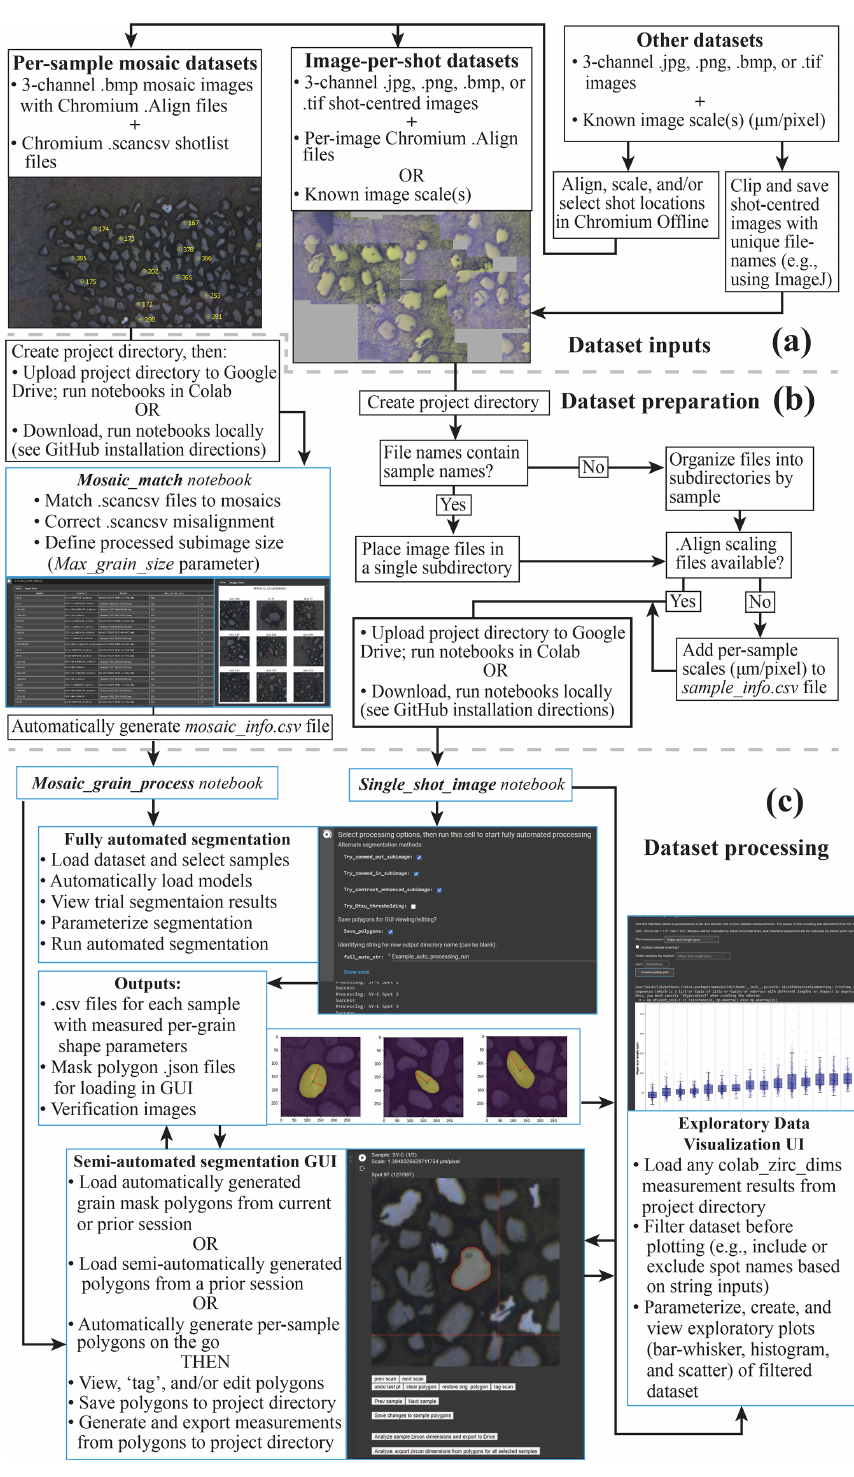
Figure 2. A graphical summary of interfaces and workflow options available in colab_zirc_dims processing notebooks. Tasks that are handled automatically or semi-automatically by processing notebooks are shown in blue boxes. (a) A summary of possible dataset inputs that can be processed or made processable with the provided notebooks. (b) Summary of the workflow for preparing datasets for fully automated or semi-automated segmentation. (c) Summary of possible workflows for automated or semi-automated grain measurement and for exploratory visualization of the resulting